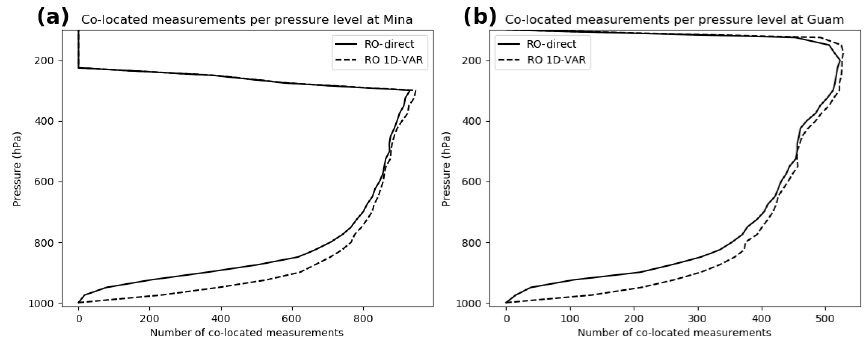
Figure 1. Number of co-located measurements for (a) Mina and (b) Guam. These are also the sample numbers in the calculations of the estimated error variances for the data sets. When using the RO 1D-VAR, the number of co-locations is slightly higher than for the RO-direct throughout the profile due to the way the 1D-VAR is